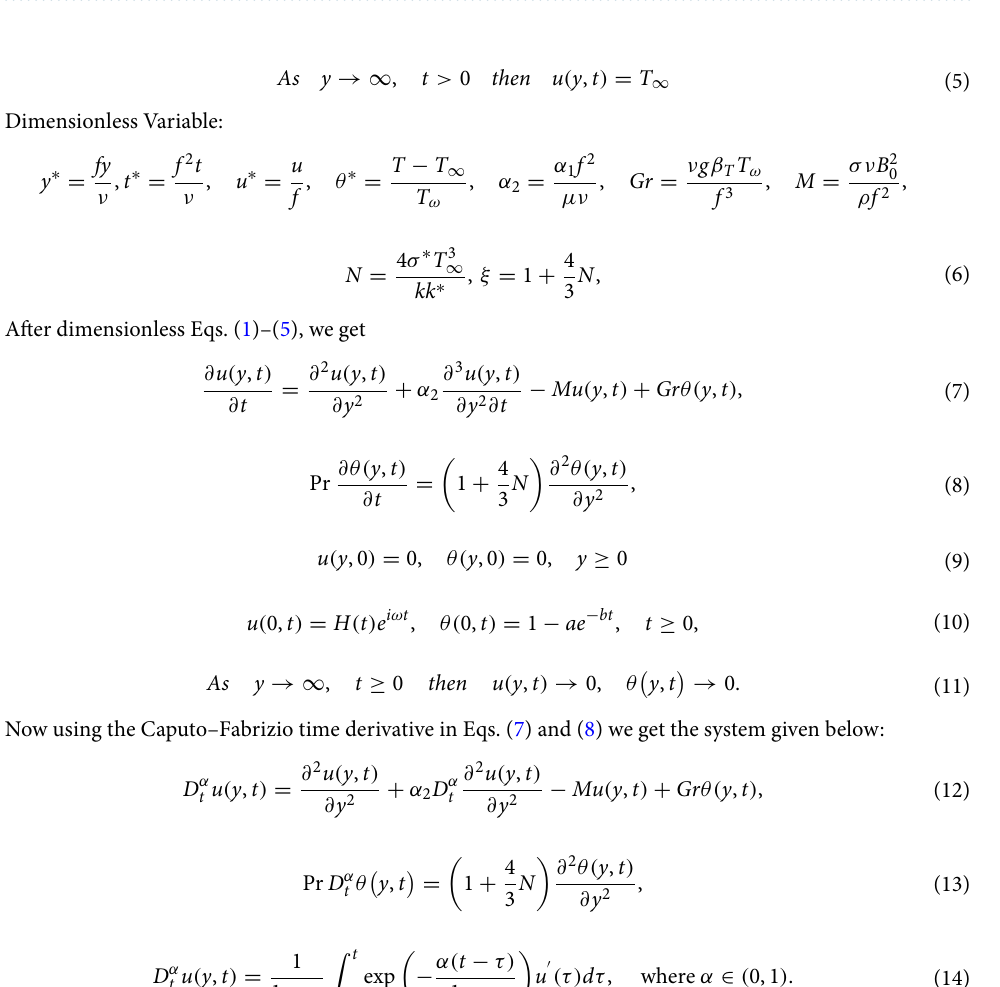
Figure 1. Geometry of the